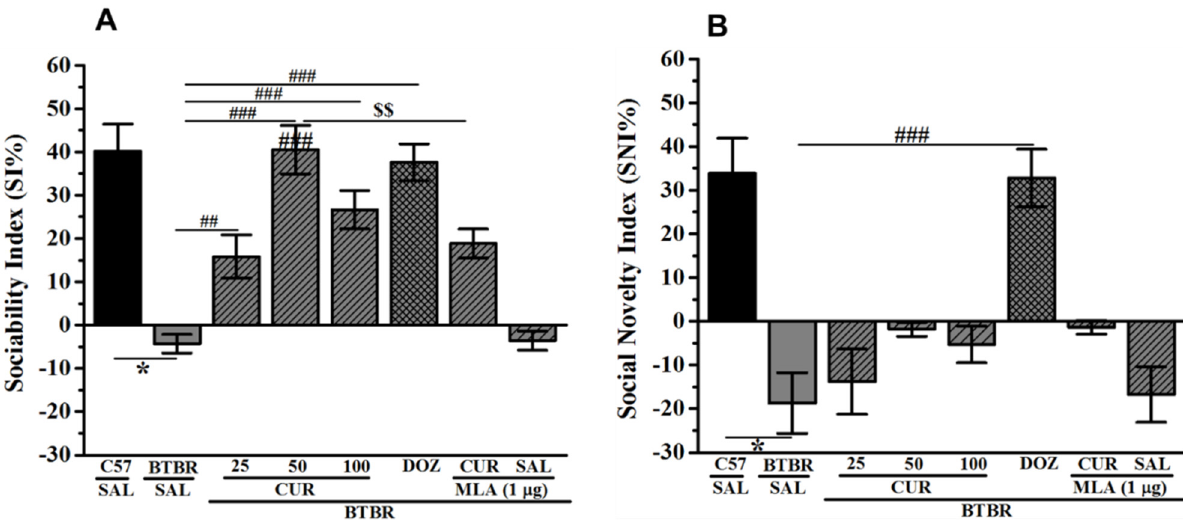
Figure 4. Effects of curcumin and donepezil on deficits of sociability and social novelty preference in BTBR mice. After 10 min of habituation, male subjects were allowed to explore all chambers for two 10 min sessions. C57 and BTBR mice were injected with saline, and BTBR mice were administered with CUR (25, 50, or 100 mg/kg, i.p.) or DOZ (1 mg/kg, i.p.) chronically for 21 days. The results obtained were Sociability Index (SI) and Social Novelty Index (SNI) (B). Also, the effects of chronic (21 days) systemic co-injection of MLA (1 µg/kg, i.p.) on the CUR-(50 mg)-provided improvement of sociability ( A ) and social novelty preference ( B ) were assessed. Figures show mean ± SEM ( n = 7). * p < 0.05 vs. SI or SNI of saline-treated C57 mice. ## p < 0.01 vs. SI of saline-treated BTBR mice. ### p < 0.001 vs. SI or SNI of saline-treated BTBR mice. $$ p < 0.05 vs. CUR-(50 mg)-treated BTBR mice.